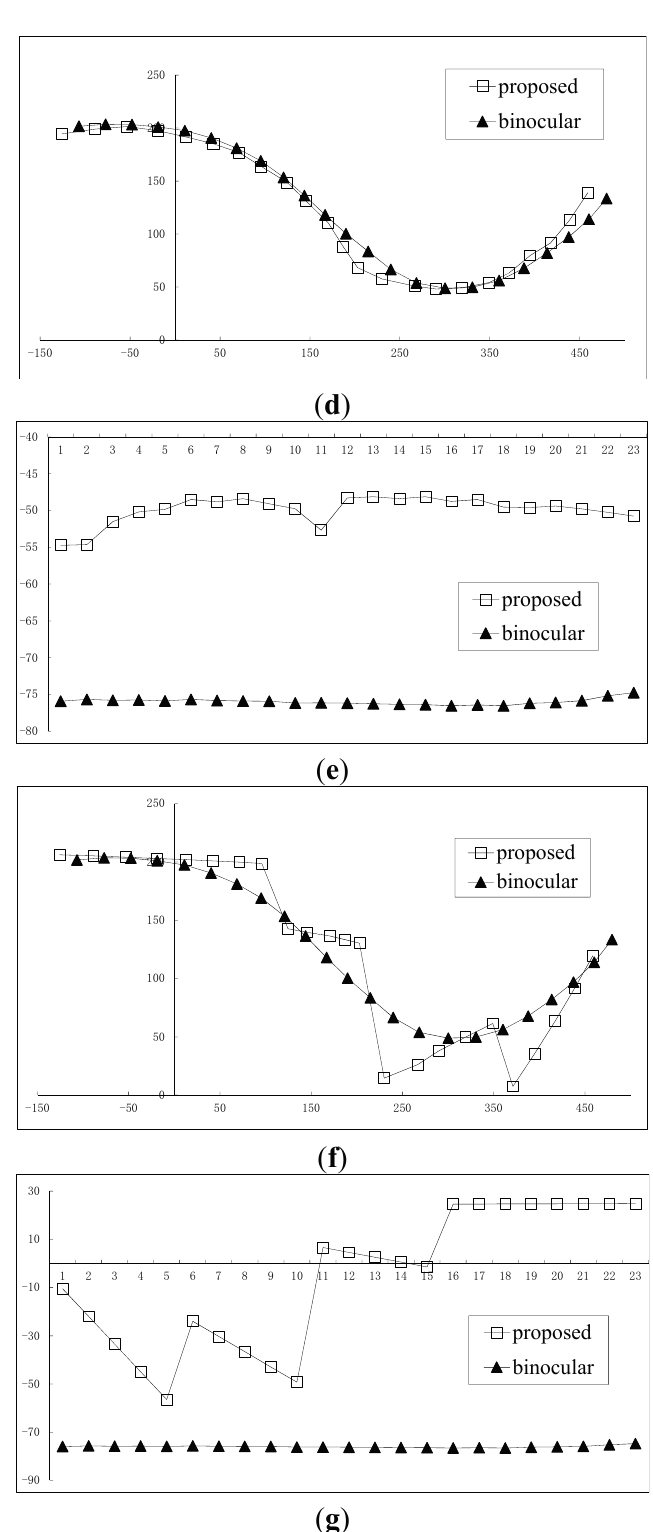
Figure 6. Reconstruction by segmentation. ( a ) The guiding line images taken by the two cameras; ( b ) The reprojection by the results of proposed method on the first image (above) and the last image (below); ( c ) The camera trajectory and the rebulit one of the point; ( d ) and ( e ) The proposed and binocular results in the XOY plane and the Z direction, respectively; ( f ) and ( g ) The proposed with four line section approximation and binocular results in the XOY plane and the Z direction,